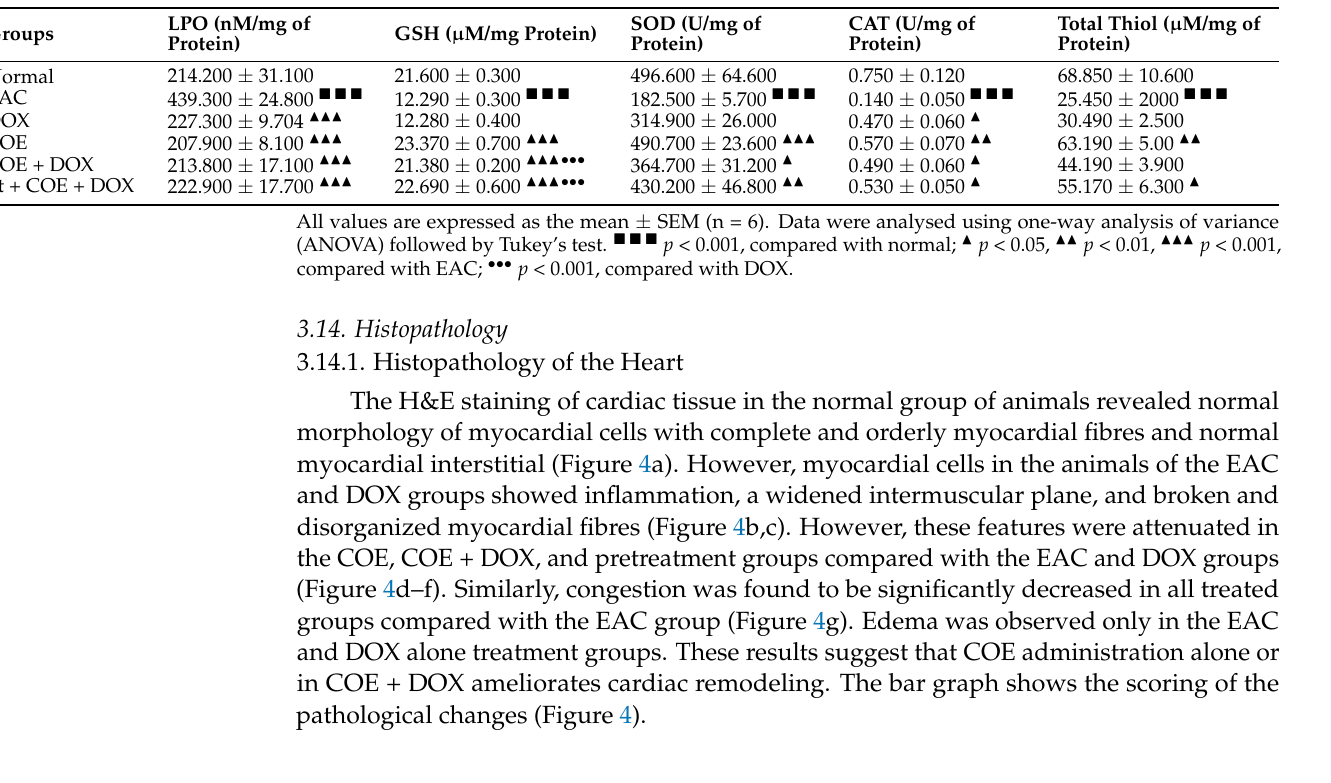
Table 9. Effect of COE on enzymatic and non-enzymatic antioxidant biomarkers in kidney